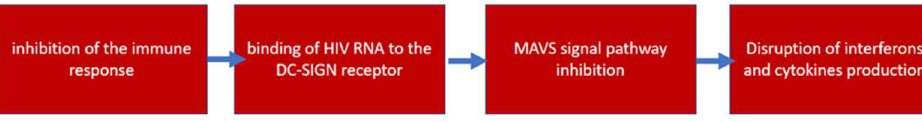
Figure 4. Scheme of inhibition of the immune response against HIV.